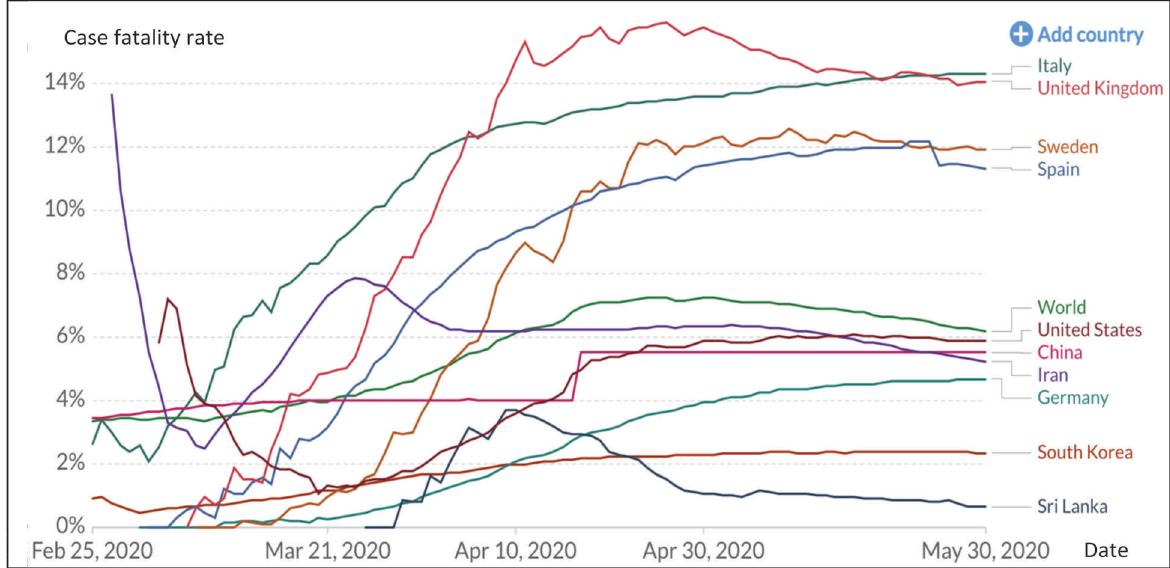
Figure 2. Comparison of CFRs of COVID-19 for several countries by 31 May